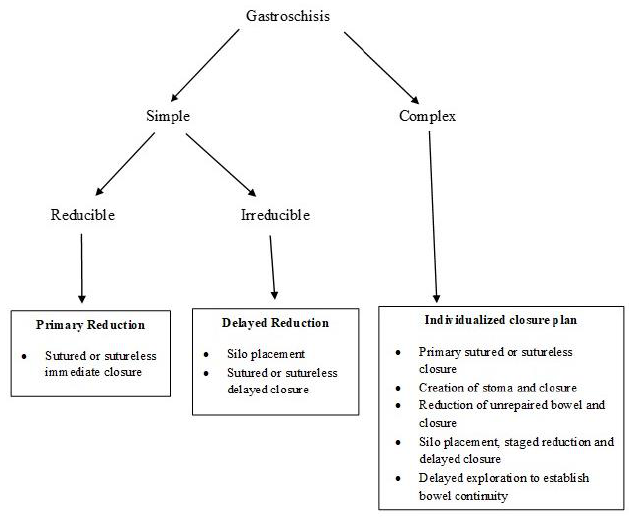
Figure 5. Algorithm for reduction and closure of gastroschisis. (Adapted from Ref. [77]).